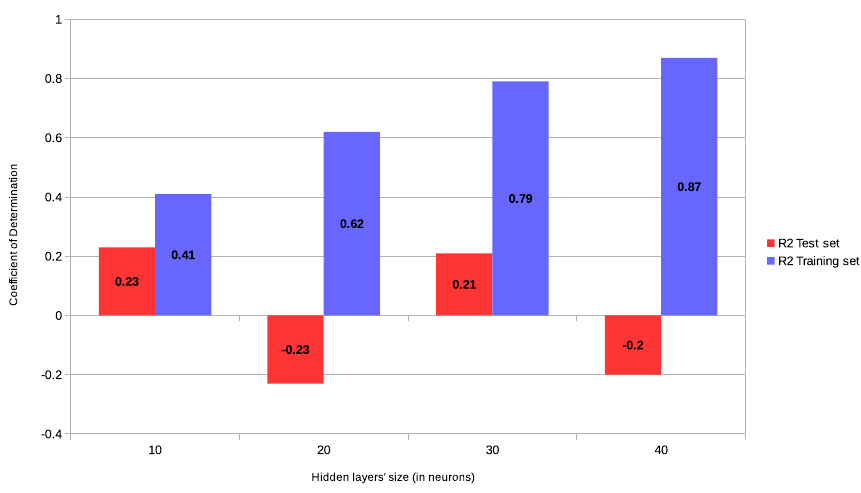
Figure 3. Regression model for primal method—tuning the number of neurons in hidden layers.